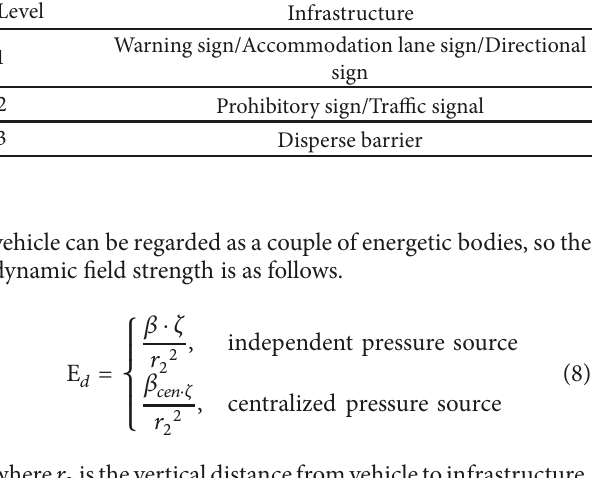
Table 5: Warning level of field source.